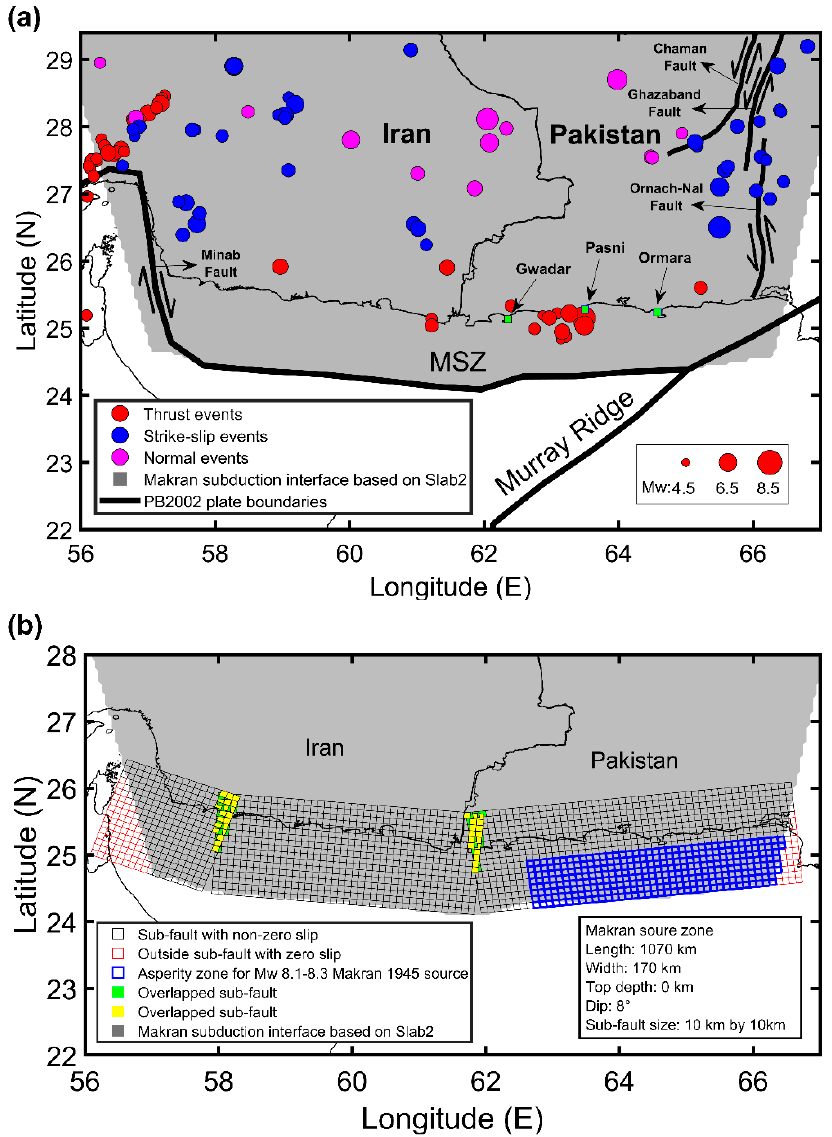
Figure 3. ( a ) Makran fault plane geometry based on Slab2 in comparison with the PB2002 geometry and ( b ) tsunami source zone model (i.e., new Makran fault plane model).